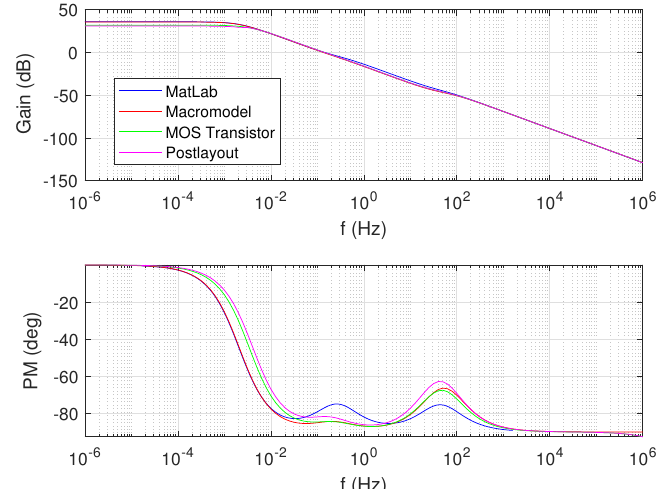
Figure 17. Comparison of the gain (up side) and phase margin (down side) responses of the fractional- order integrator H ( s ) = 1/ s 0.9 , considering the ideal transfer function approximation in MATLAB, macro-modeling the OTAs, HSPICE simulation using MOS transistor models, and post-layout simulation. It is important to mention that the initial values of the CMOS fractional-order integra- tor, do have an effect on the power consumption. If the initial values are large, the power consumption of the CMOS circuit increases since both the transient time and the voltage on the capacitors increase. Using small initial values, the power consumption is 149.8 µ W. PVT variations analyses are performed to ensure robustness of the fractional-order integrator response. For instance, Figure 18 shows the AC response under PVT variations. Each of the five corners (typical–typical (TT), fast–fast (FF), slow–slow (SS), slowN–fastP (SNFP) and fastN–slowP (FNSP)) is simulated by varying 10% of the supply voltage and varying the temperature from − 20 ◦ , 60 ◦ , to 120 ◦ . The variability due to